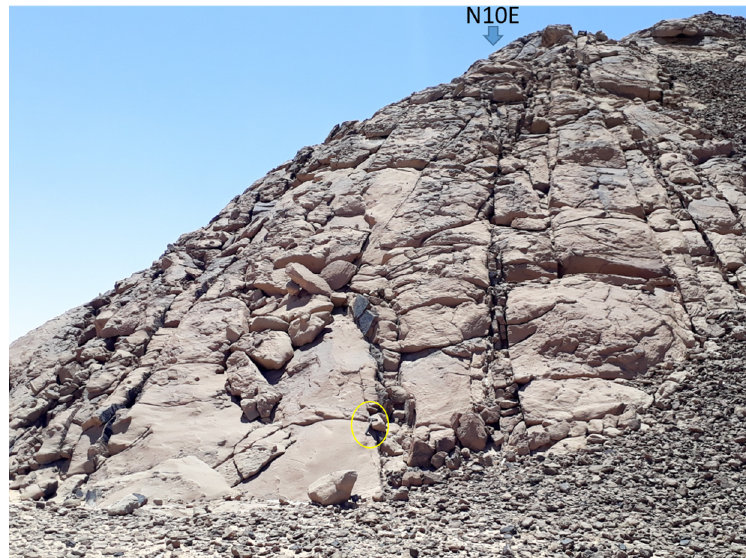
Figure 15. Photograph shows the N10 E-trending fracture set within the Wajid sandstone outcrop close to an agricultural area, Wadi Al-Dawasir.